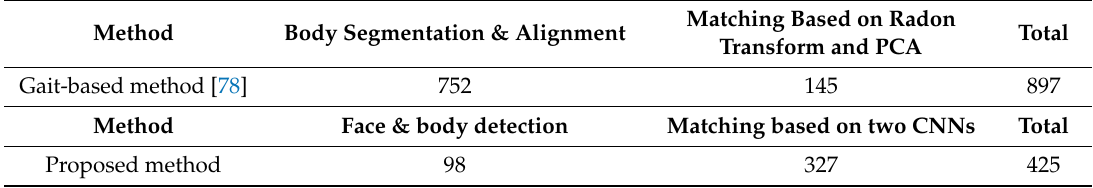
Table 13. Comparison of processing time per an image by proposed and previous method (unit: